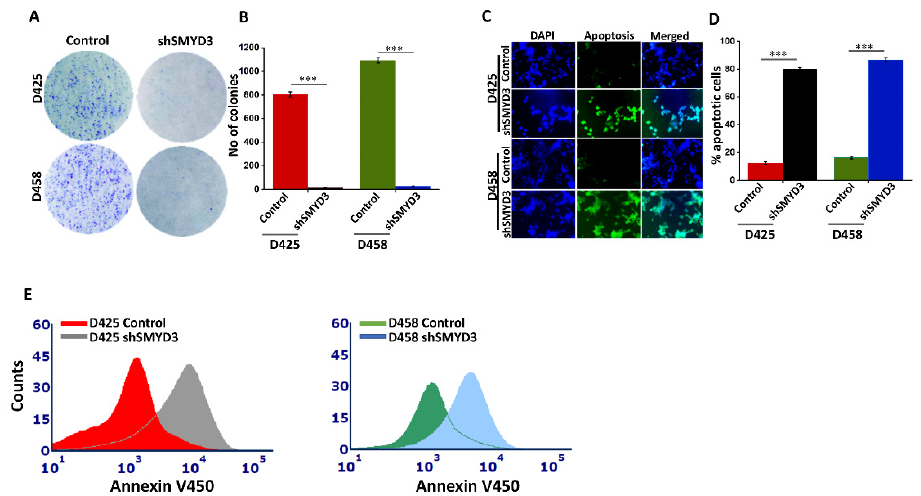
Figure 8. SMYD3 knockdown functionally impairs MB cell proliferation. ( A ) Clonogenic assay using SMYD3 silenced and control D425 and D458 cells. ( B ) Colonies were quantified manually and graphically represented in the control and SMYD3 silenced cells. ( C ) Tunnel assay showing the apoptotic cells (green) and the nucleus (blue) in D425 and D458 cells. The fluorescence intensity was quantified using Image J. ( D ) Bar graph showing the percentage of apoptotic cells in shSMYD3 treated cells, compared with the control cells. ( E ) Annexin V assay using the RayBio ® Annexin V450 apoptosis kit in the control and shSMYD3 treated D425 and D458 cells. The statistical significance *** p < 0.001.